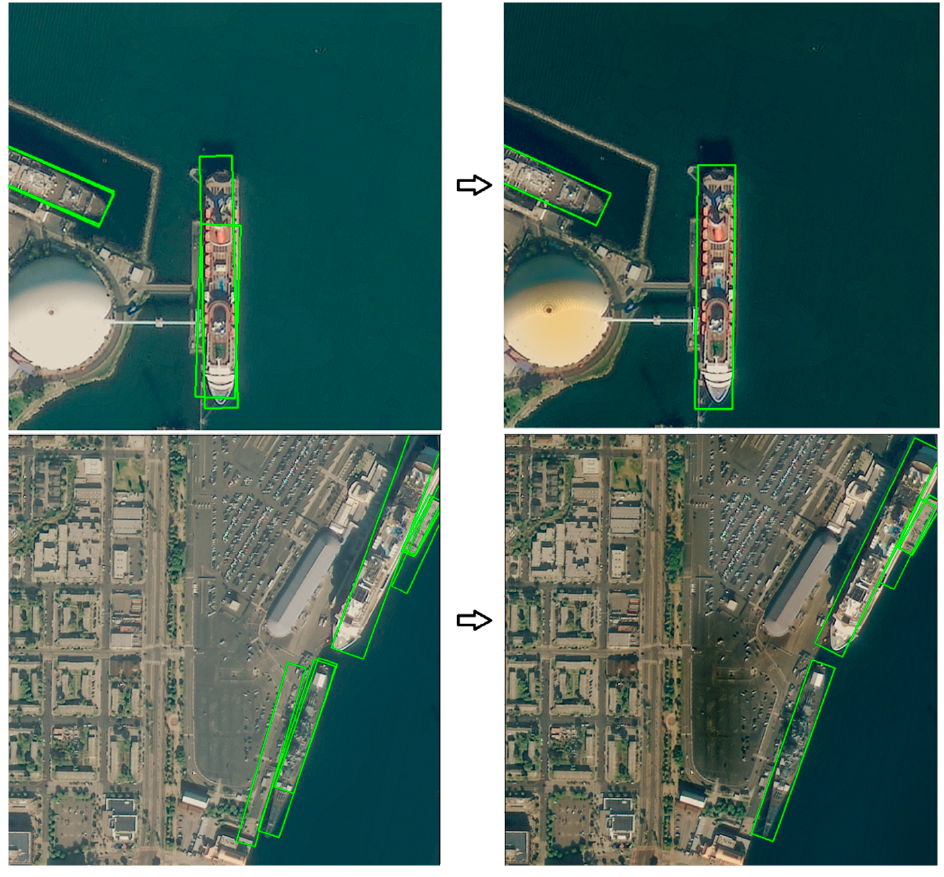
Figure 13. Display of test results before and after model improvement—small target missed detec- tion improvement.